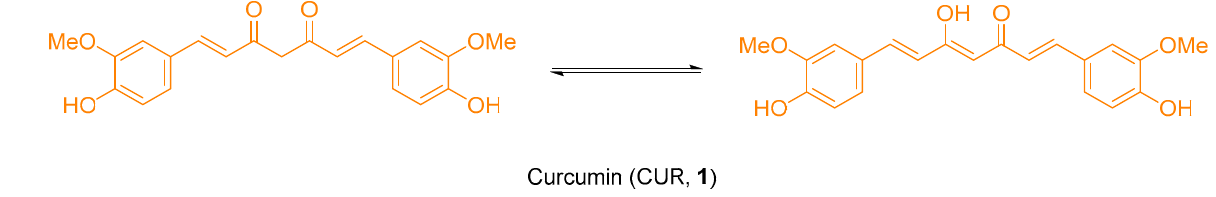
Figure 1. Keto-enol tautomeric forms of curcumin (CUR).